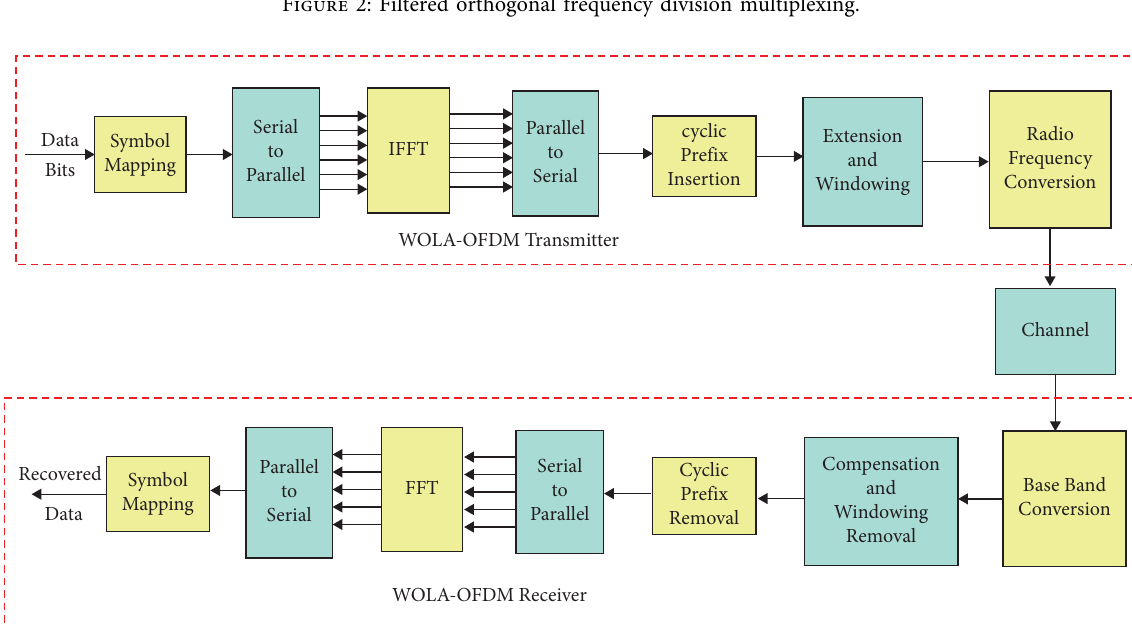
Figure 3: Weighted overlap and added orthogonal frequency division multiplexing